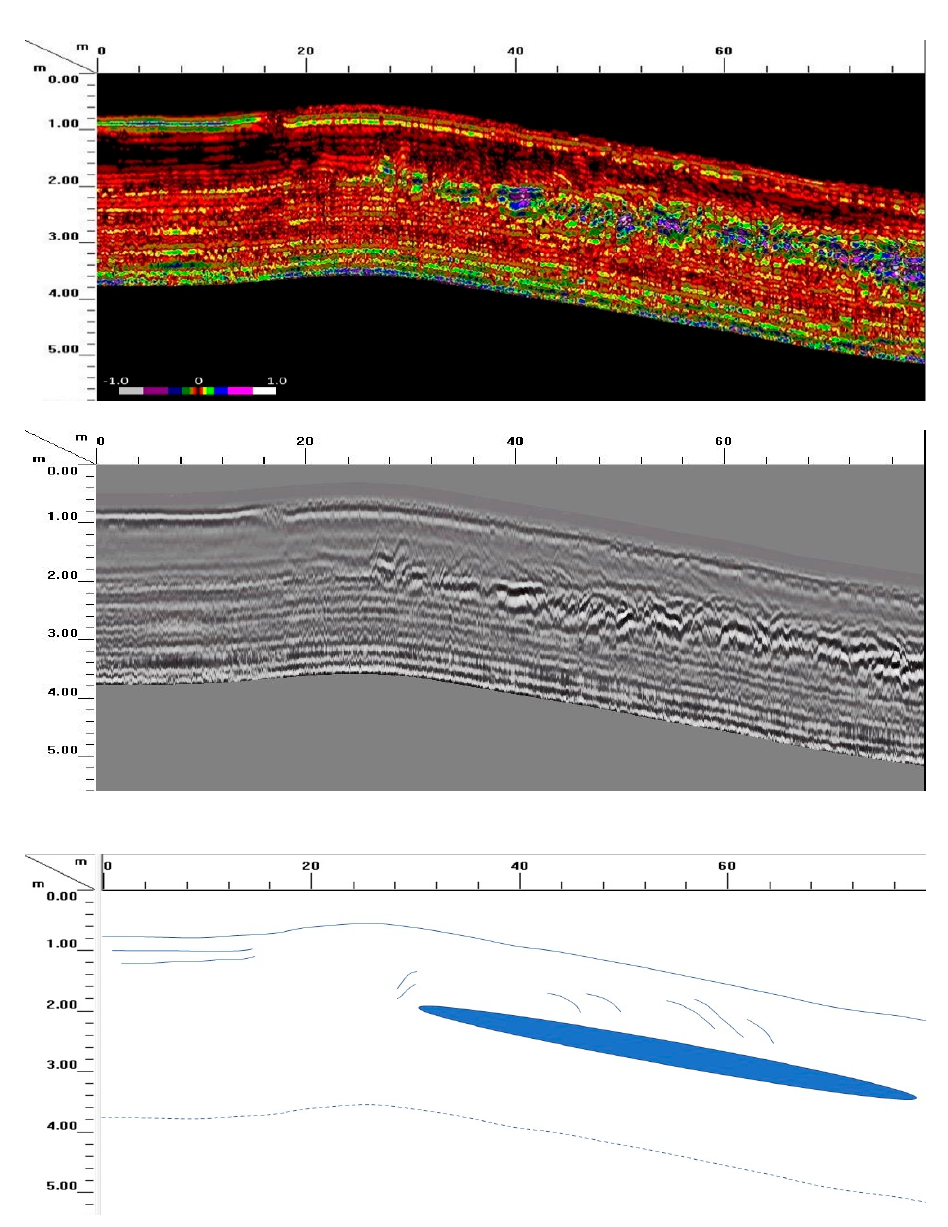
Figure 14. GPR profile and interpretation for the 1715 m shoreline. In the upper transect, data are presented with a color scale to highlight the normalized intensity of radar reflectors. The lower profile presents the same data in grayscale. In both profiles, landward is to the left and lakeward is to the right. The blue oval designates the overall zone of high-amplitude reflectors seen beneath the lakeward slope of the beach ridge. Vertical exaggeration 5×.